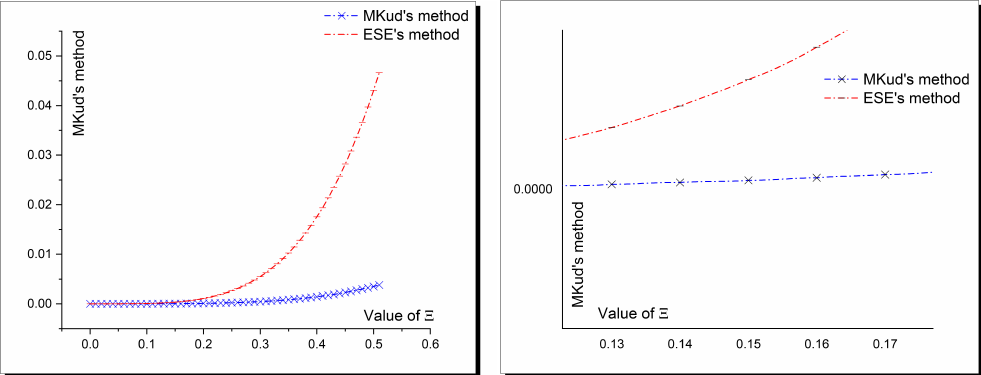
Figure 7. MKud method’s